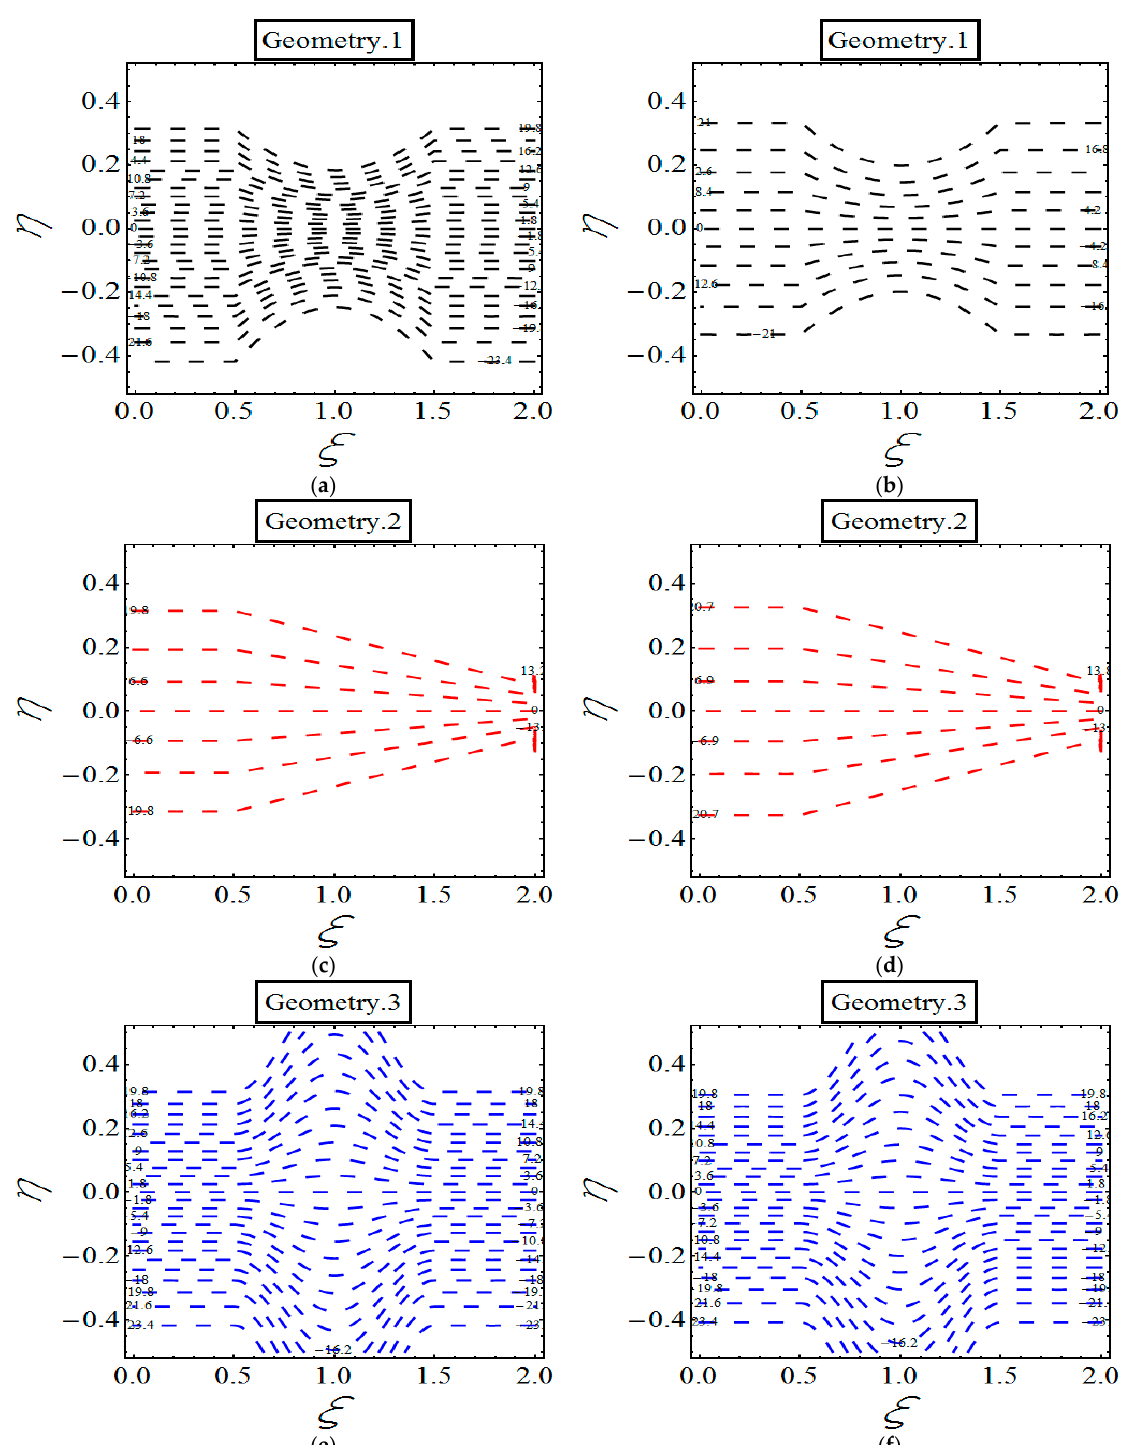
Figure 11. Stream lines for various electro–osmotic parameters m = 2 ( a , c , e ) and m = 5 ( b , d , f ) in three geometries.